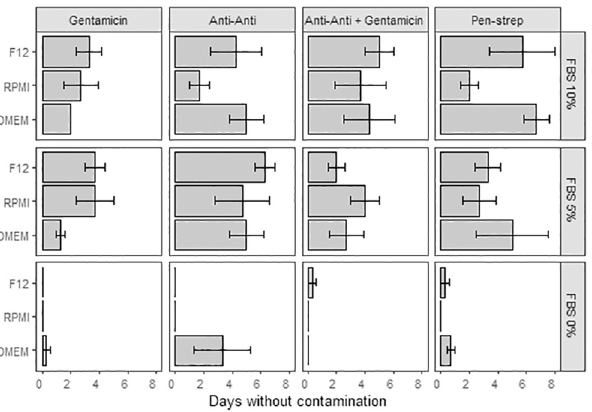
Fig 6. Cell culture contamination variations. Average contamination free cell culture duration (days ± SE) as a factor of media type (F12, RPMI, DMEM), serum (0%, 5%, 10%) and antibiotic (Gentamicin, Anti-Anti: Antibiotic- Antimycotic, Anti-Anti + Gentamicin, Pen-Strep: Penicillin-Streptomycin). Thirty-six combinations [media + serum + antibiotic] tested with three replicates per combination. [ANCOVA: df = 6, F = 0.48, p = 0.82].